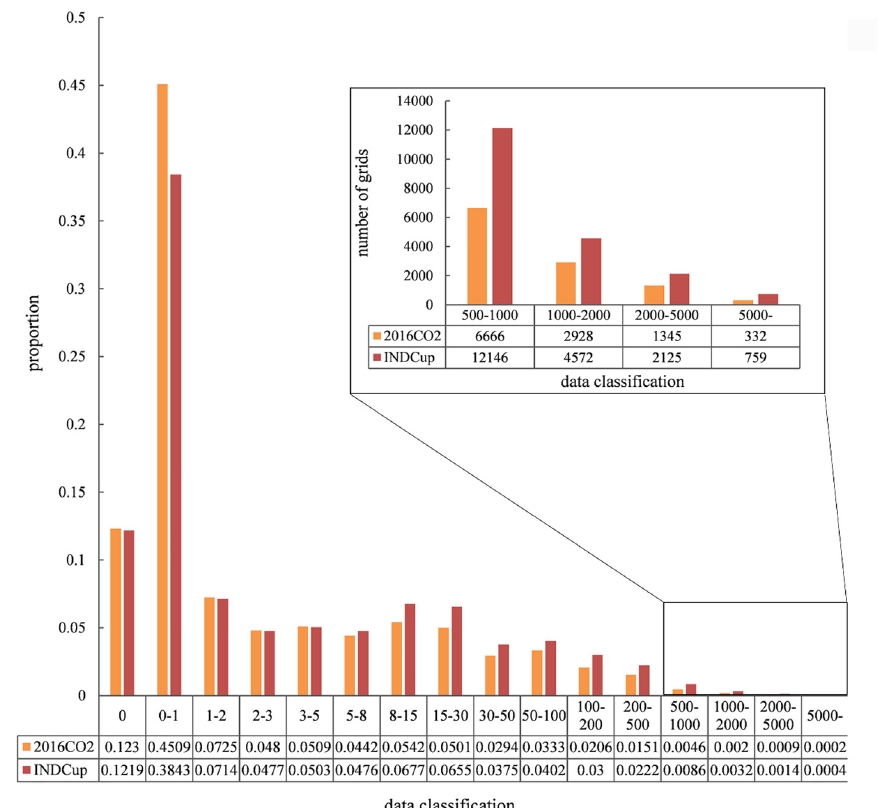
Figure 10. Comparison of